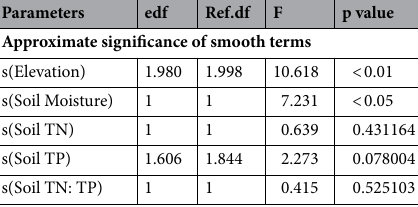
Table 4. General additive model for other tree species to evaluate interaction among parameters. R-sq. (adj) = 0.728 Deviance explained = 78.2%. GCV = 45.069 Scale est. =